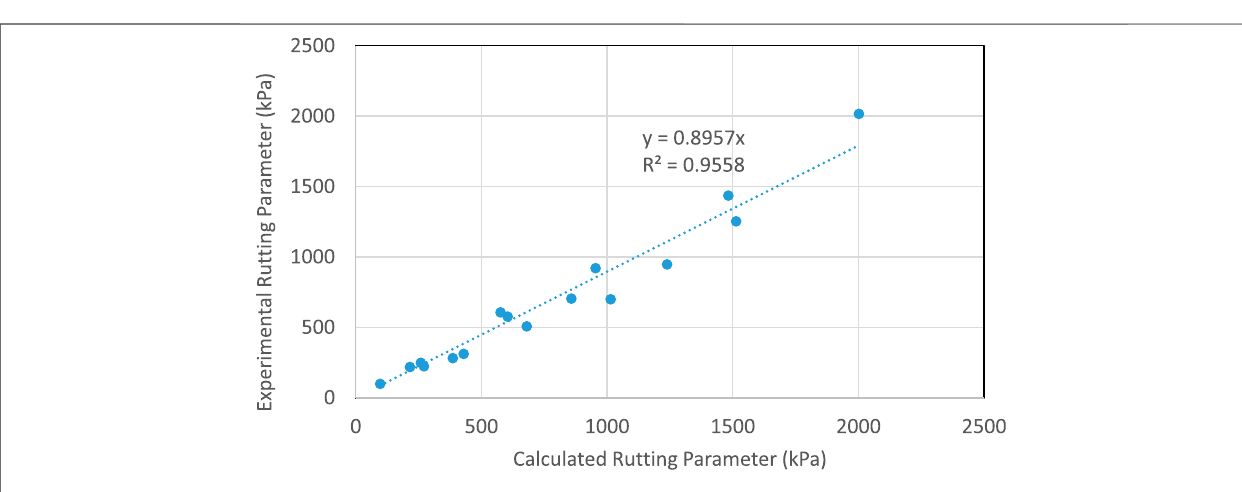
Frontiers in Built Environment |